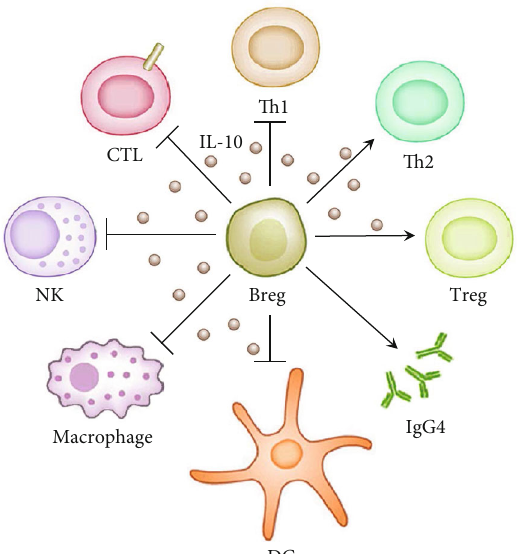
Figure 2: The function of Breg. Breg can promote Th2 cell di ff erentiation and inhibit Th1 cell di ff erentiation by secreting IL- 10. In addition, its secretion of inhibitory cytokines such as IL-10, TGF- β , and adenosine can inhibit the activity of NK cells, monocytes, and CTL, and impair the antigen presentation function of dendritic cells. In addition, some Bregs can also promote the di ff erentiation of Treg, enhance the immune regulation e ff ect, and secrete IgG4 blocking autoantibodies to protect the body from hypersensitivity